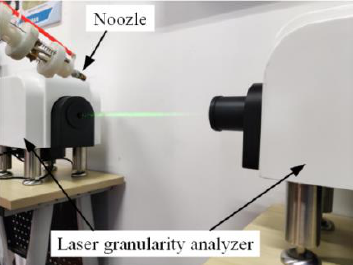
Figure 14. The measurement experiment to test the droplet diameter.